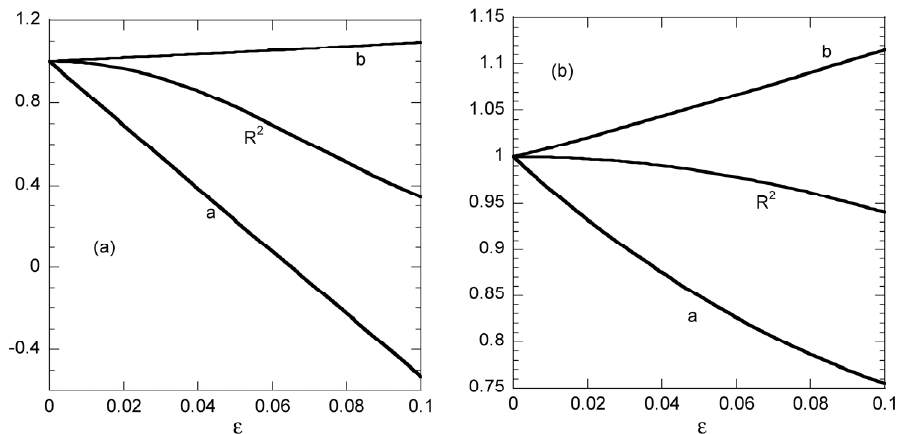
Figure 4. Example 3: Pseudo-second order linear fit extracted parameters a and b and nonlinear fit correlation coefficient versus “experimental error” parameter ε ( a ) Case 1 sampling times, ( b ) Case 2 sampling times.